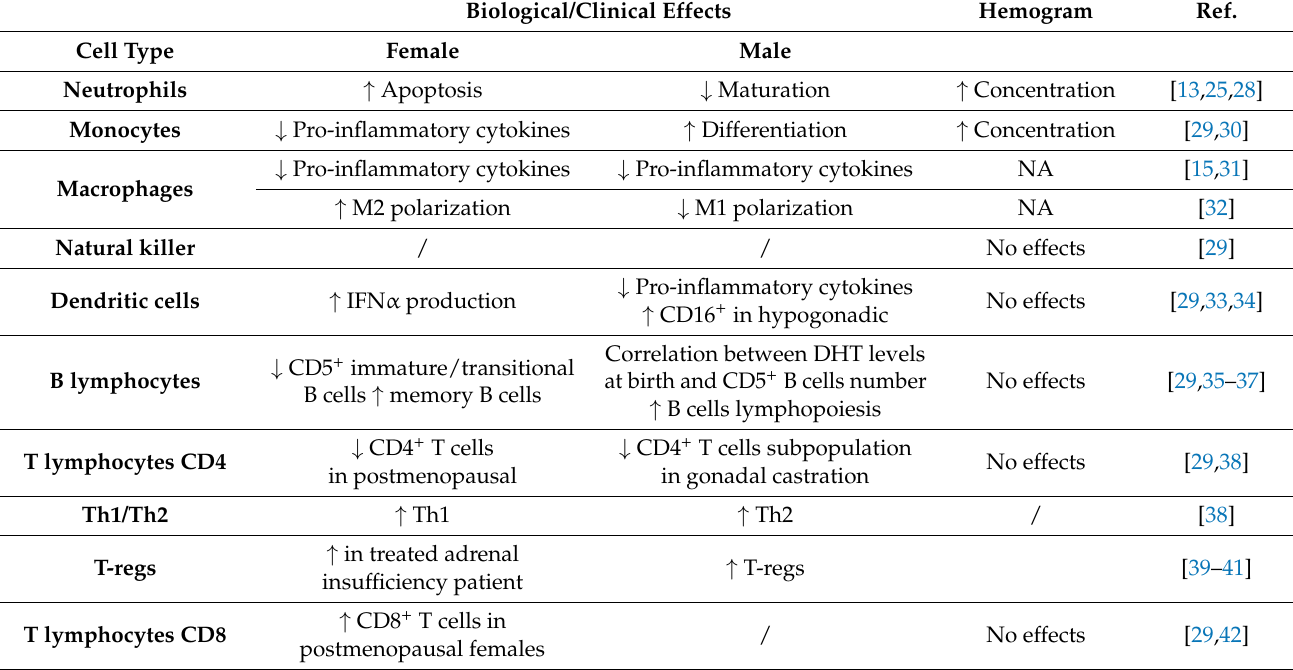
Table 1. Biological and clinical effects of androgens on immune cell types. Biological/Clinical Effects